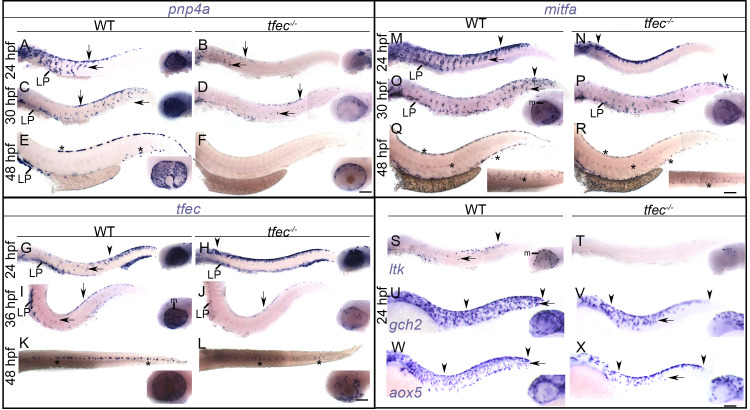
Specification of melanocytes, iridophores and xanthophores is delayed in tfec mutants.(A-F) pnp4a expression in Ib(sp) requires Tfec. At 24 hpf, the number of dorsally located, and of partially fate restricted, migrating chromatoblasts (arrows) expressing pnp4a is reduced in tfec mutants (A,B). Expression overlying the eye is also affected (A,B, insets). This reduction is still prominent at 30 hpf (C,D), when staining is also visibly affected in the lateral patches. pnp4a expression is undetectable in differentiated iridophore positions (E, asterisks) in tfec mutants at 48 hpf (F). pnp4a+ iridophore lineage cells overlying the RPE are noticeably reduced in tfec mutants compared to WT siblings (A-F, insets). (G-L) Generation of tfec-positive Ib(sp) from late Cbls requires Tfec. At 24 hpf, tfec mutants present with anterior expansion of the tfec+ premigratory NC domain (G,H, arrowheads) and lack of medially migrating, Ib(sp) progenitors (arrows). At 36 hpf, the number of dorsal and migrating tfec+ Ib(df) (arrows), as well as those located in the lateral patches is reduced in mutants, compared to WT or heterozygous siblings (I,J). At 48 hpf, a reduced number of cells (asterisks) express tfec along the dorsal stripe of mutant embryos, compared to WT or heterozygous siblings (K,L). tfec mutant embryos were distinguishable after whole-mount in situ hybridisation by the lack of RPE melanisation (I-L, insets). tfec+ iridophore lineage cells overlying the RPE are noticeably reduced in tfec mutants compared to WT siblings (G-L, insets). (M-R) Mb(sp) generation from the late Cbl is delayed in tfec mutants. At 24 hpf, mitfa marker expression is restricted to an increased number of premigratory Cbls (arrowheads) and is undetectable in migrating Mb(sp) (arrows) in tfec mutants (M,N). At 30 hpf, the numbers and distributions of mitfa-positive late Cbls (arrowheads) are indistinguishable between tfec mutants and WT or heterozygous siblings (O,P), but the delay in Mb(sp) migration (arrows) remains distinguishable towards the tail. tfec mutant embryos lack RPE melanisation (O,P, insets). At 48 hpf, mitfa expression in mature melanocytes (asterisks) is indistinguishable between tfec mutants and WT or heterozygous siblings (Q,R). (S, T) tfec mutants lack ltk expression in premigratory late Cbls (arrowhead), in migrating Ib(sp) (arrow) and in iridoblasts of the eye (insets). (U-X) Xanthoblast (Xbl(sp)) specification from Cbls is delayed, as indicated by examinations of two lineage markers, gch2 (U,V) and aox5 (W,X). At 24 hpf, laterally migrating Xbl(sp) (arrows) are restricted to more anterior regions and precursors located in the head are reduced in tfec mutants (V,X) compared to their WT siblings (U,W). All tfec mutant panels show the tfecba6 allele except (V,X) which show the tfecvc60 allele. LP, lateral patches; m, melanisation. (A-J,M-X): lateral views. (K-L, insets of Q-R): dorsal views. Head towards the left. Scale bars: 100 μm.